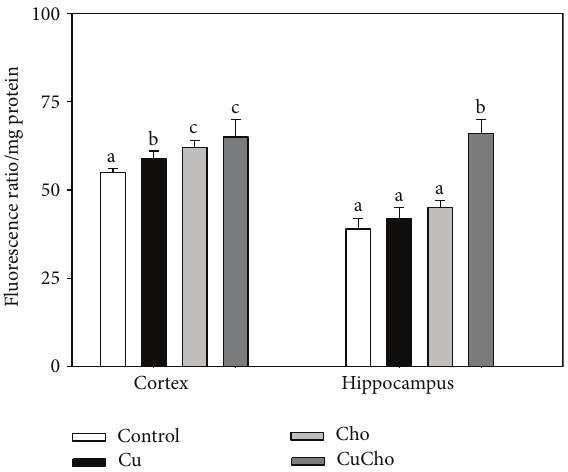
Figure 4: Mitochondrial glutathione (mGSH) content in brain cortex and hippocampus (ng/mg total protein). Treatments are indicated with different colors, control (white bars), Cu (black bars), Cho (gray bars), and CuCho (dark gray bars). Samples were analyzed as indicated in Section 2.10. Results are expressed as mean of 10 rats assayed in triplicate ± standard deviation (SD). Significant differences among the experimental groups are indicated with superscript letters (values with distinct letters are significantly different between them, 𝑃 < 0.01 ). Table 2: Ratio A 𝛽 (1–42)/(1–40) in plasma and brain cortex and hippocampus after the experimental diets.